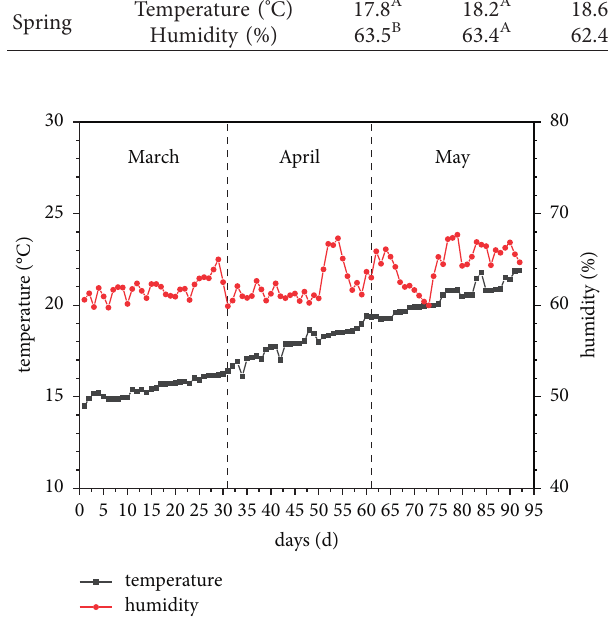
Figure 3: Daily temperature and humidity in the hog house during the experiment.